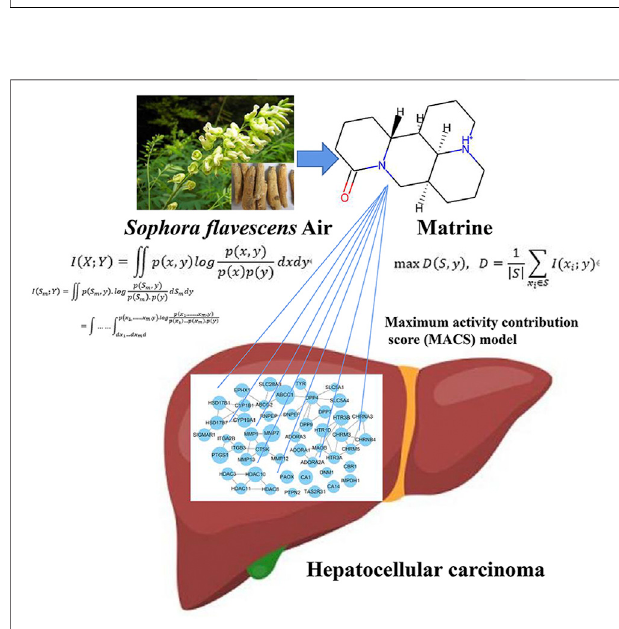
FIGURE 11 | The schematic diagram of matrine mediated metabolic network anti-HCC based on computational metabolomics approach.